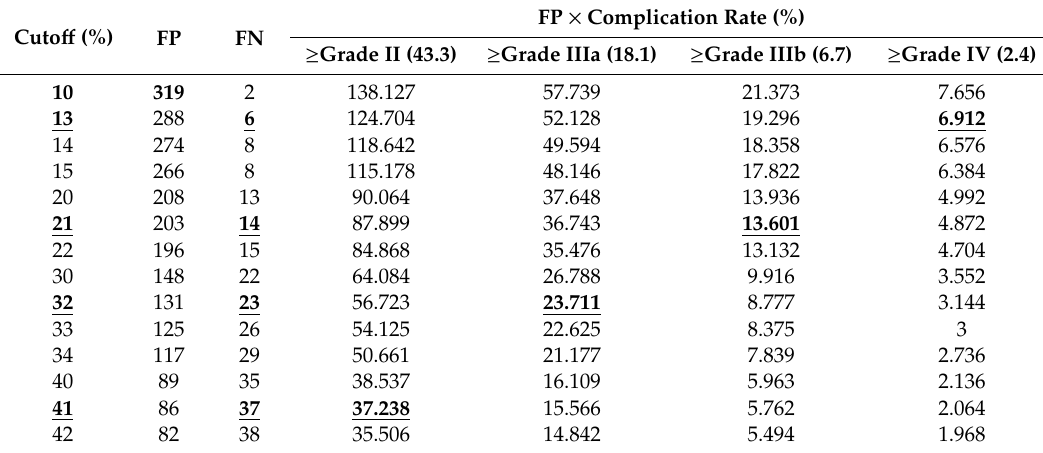
Table 1. Variables of calculation method according to the cuto ff and the severity of complications in the pancreaticoduodenectomy group ( n = 464).